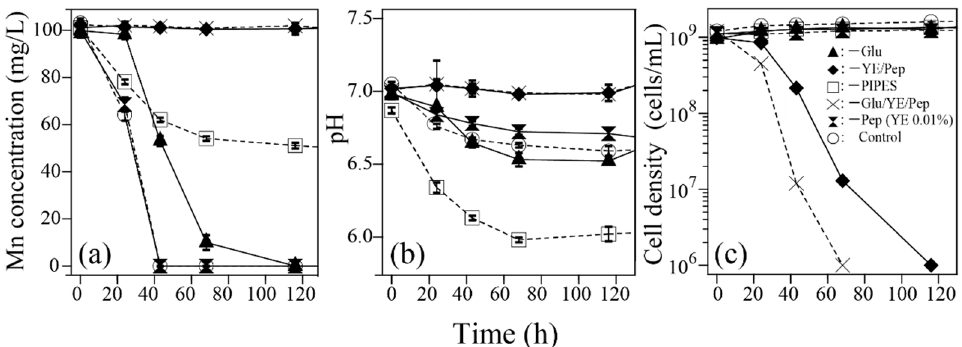
Figure 7. Effect of individual PYG-1 medium components on Mn(II) oxidative removal. Changes in